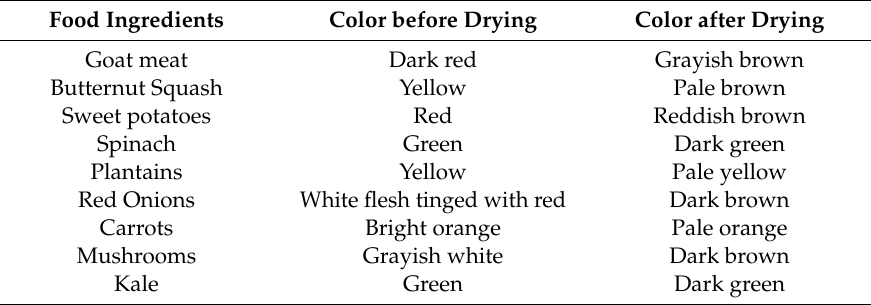
Table 2. Color transformation after drying of food samples. Food Ingredients Color before Drying Color after Drying Goat meat Dark red